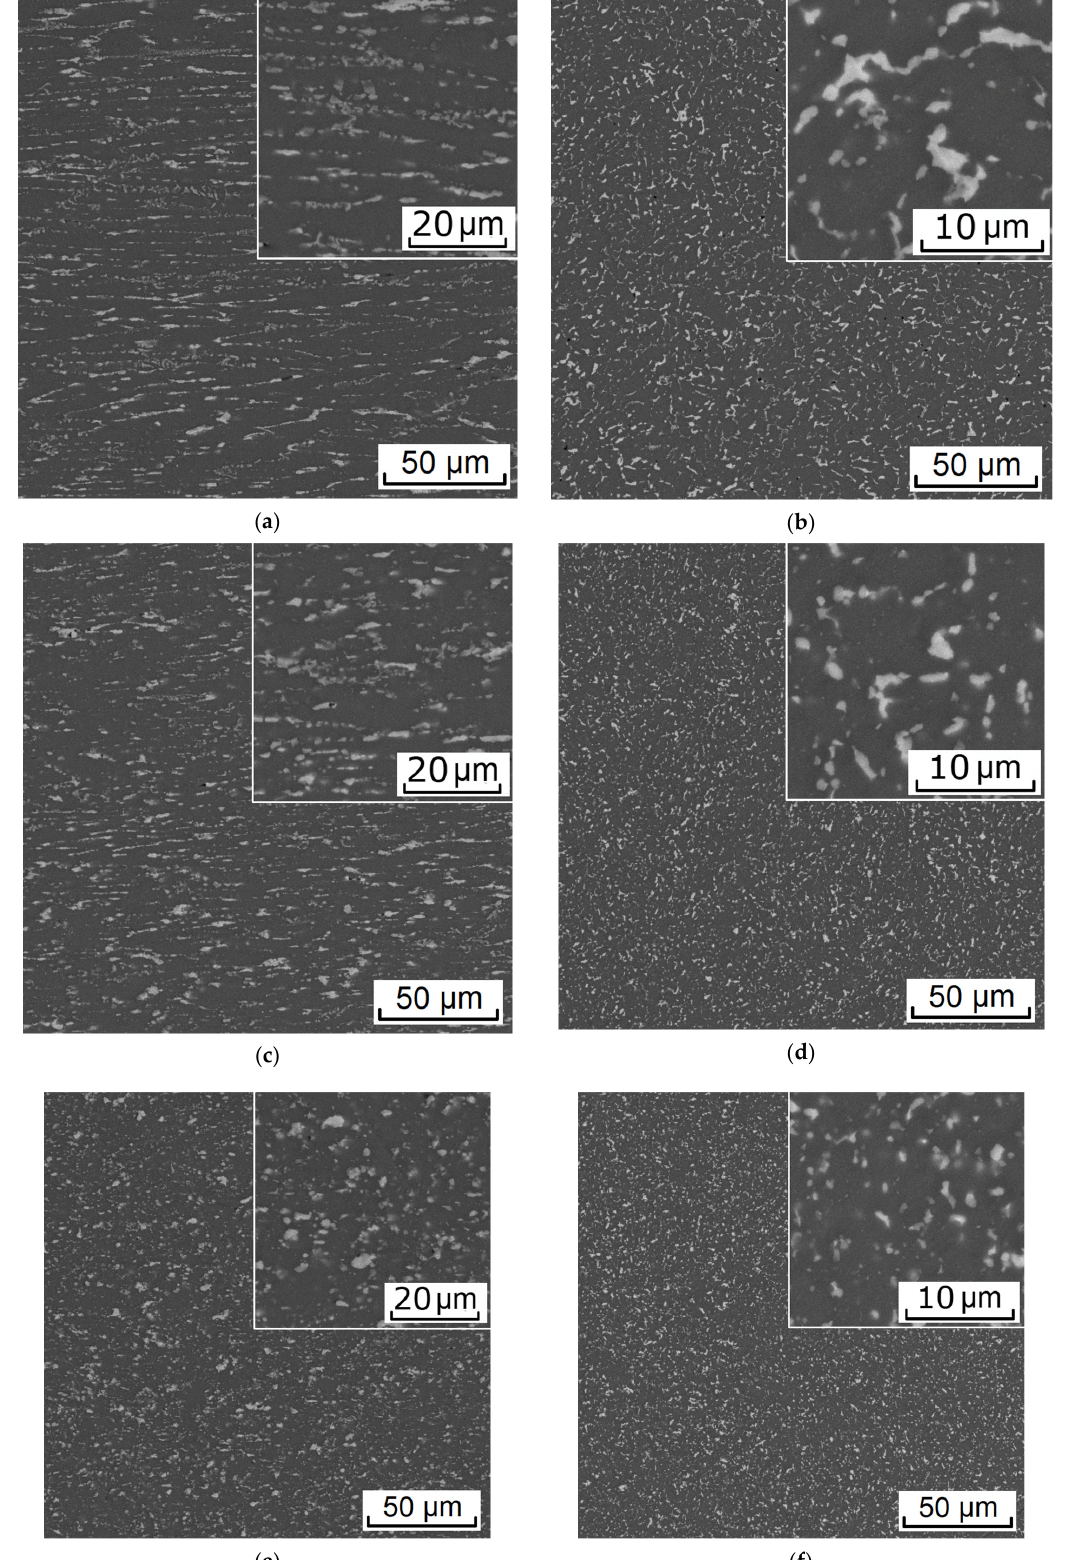
Figure 9. Microstructure (SEM) of the experimental alloy processed RSR: ( a , b ) center, ( c , d ) ½ radius, and ( e , f ) edge. ( a , c , e ) Longitudinal section and ( b , d , f ) transverse section. To estimate the degree of hardening in different zones of the rod processed by RSR, the effect of aging time at 150 °C on the hardness (after quenching from 450 °C) was stud ‐ ied. It was found that after 3 h of exposure, the hardness in the center of the rod was approximately 20 HV lower than in the remaining zones (Figure 10). However, after 6 h, the hardness values almost levelled out (195–200 HV).